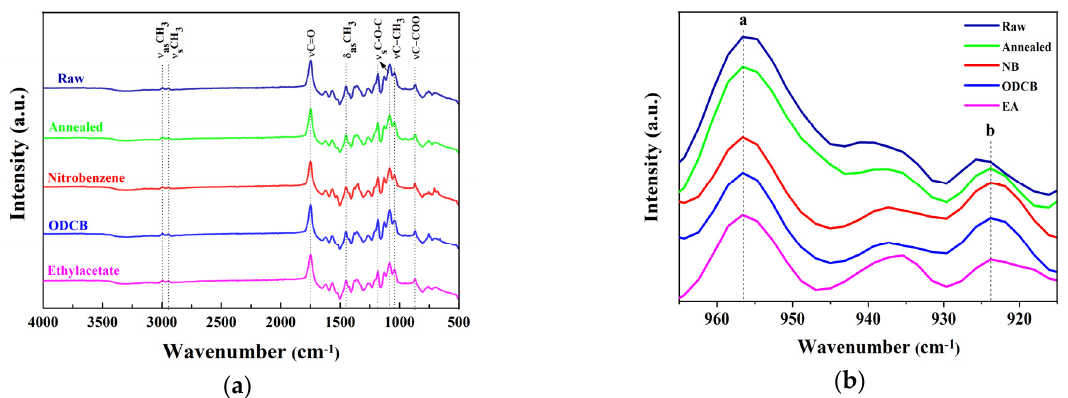
Figure 5. FTIR spectra of raw, annealed and solvent treated PLLA (at 100 ◦ C, 20min) ( a ); Enlarged FTIR spectra of 5a curve in the range 965–915 cm − 1 ( b ).